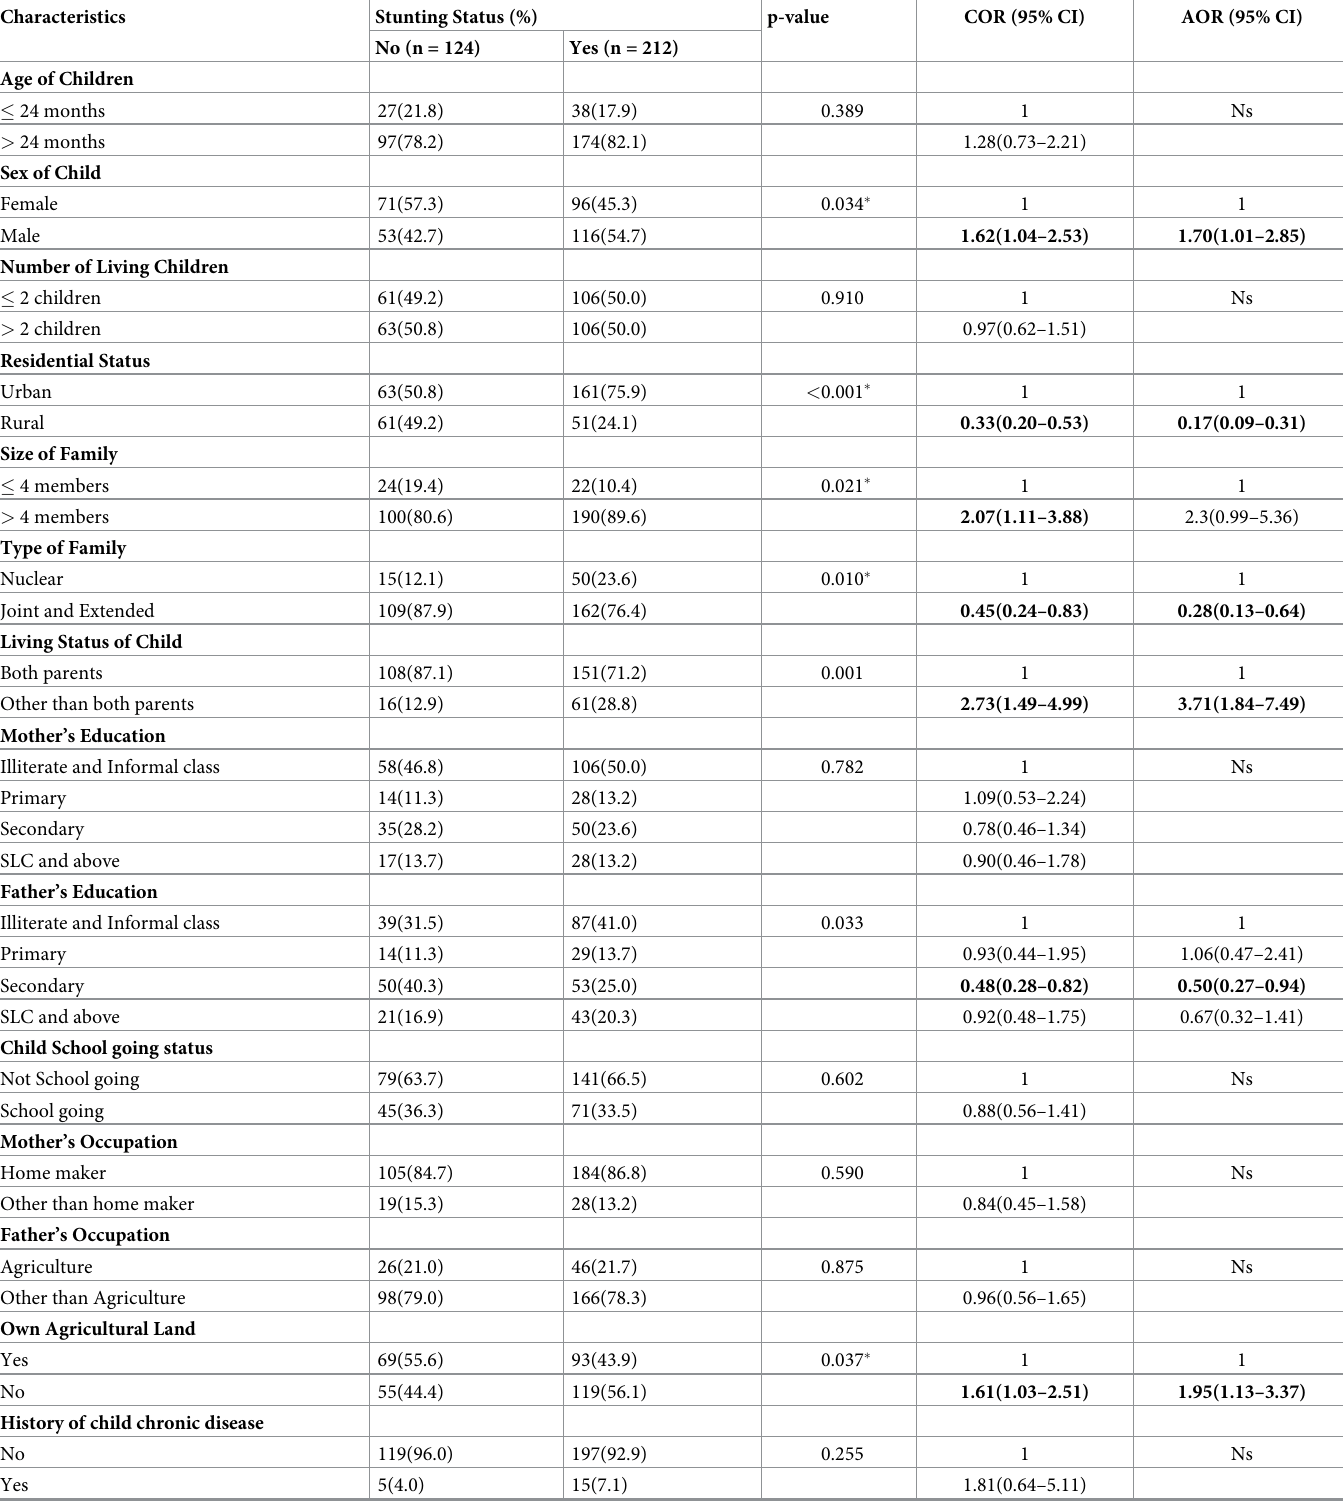
Table 6. Factors associated with Stunting in using bivariate and multivariate regression model.